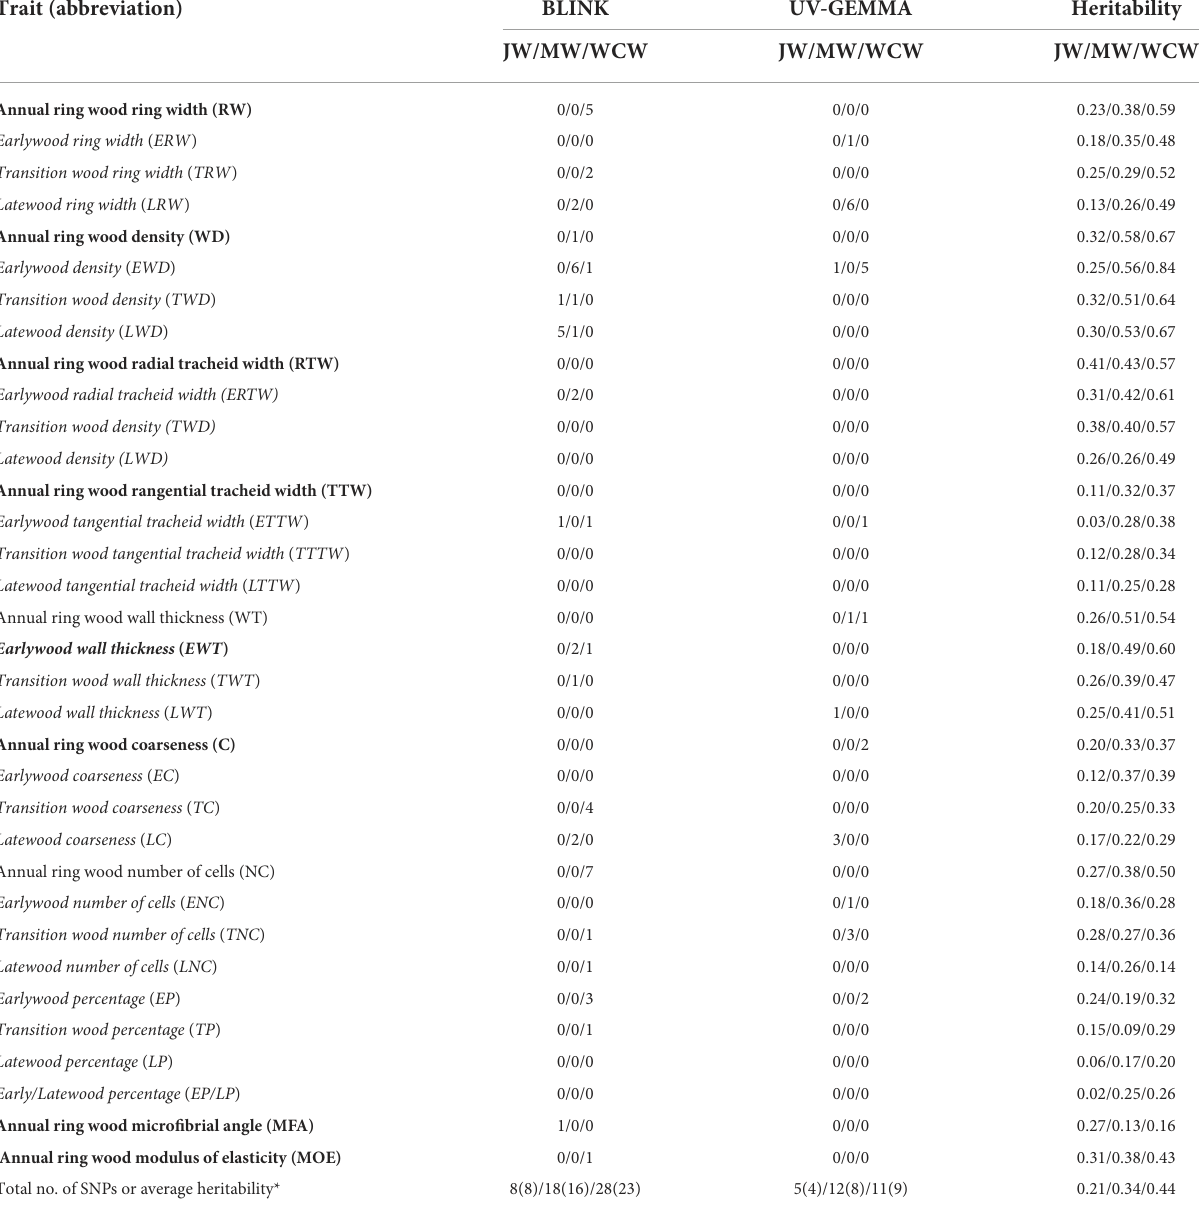
TABLE 1 List of the measured traits, their abbreviations, the number of independent SNPs detected, and the pedigree-based narrow-sense heritability for three wood types (JW/MW/WCW) based on 524 half-sib families. Trait